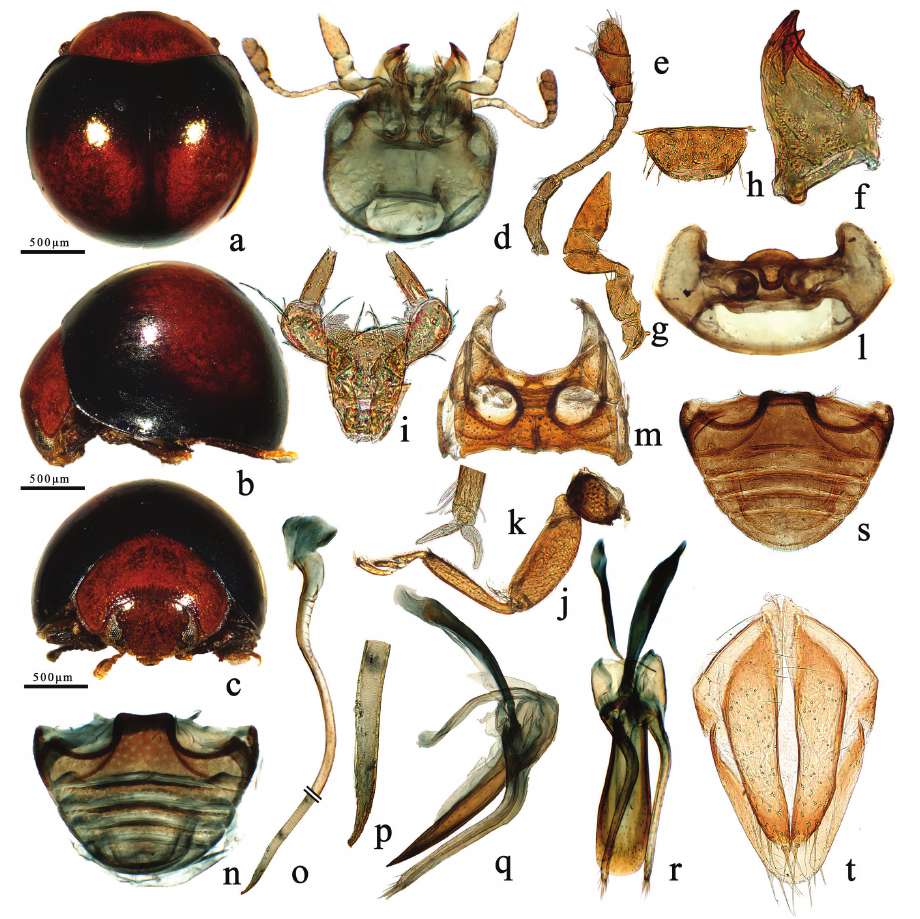
Figure 1. Morphological characters of the genus Filipinolotis . a–t F. latefasciata Miyatake. a dorsal habi- tus b lateral habitus c frontal habitus d head, ventral e antenna f mandible g maxilla h labrum i labium j front leg k tarsal claws l prothorax, ventral m mesoventrite and metaventrite n male abdomen o penis p apex of penis q tegmen, lateral view r tegmen, ventral view s female abdomen t